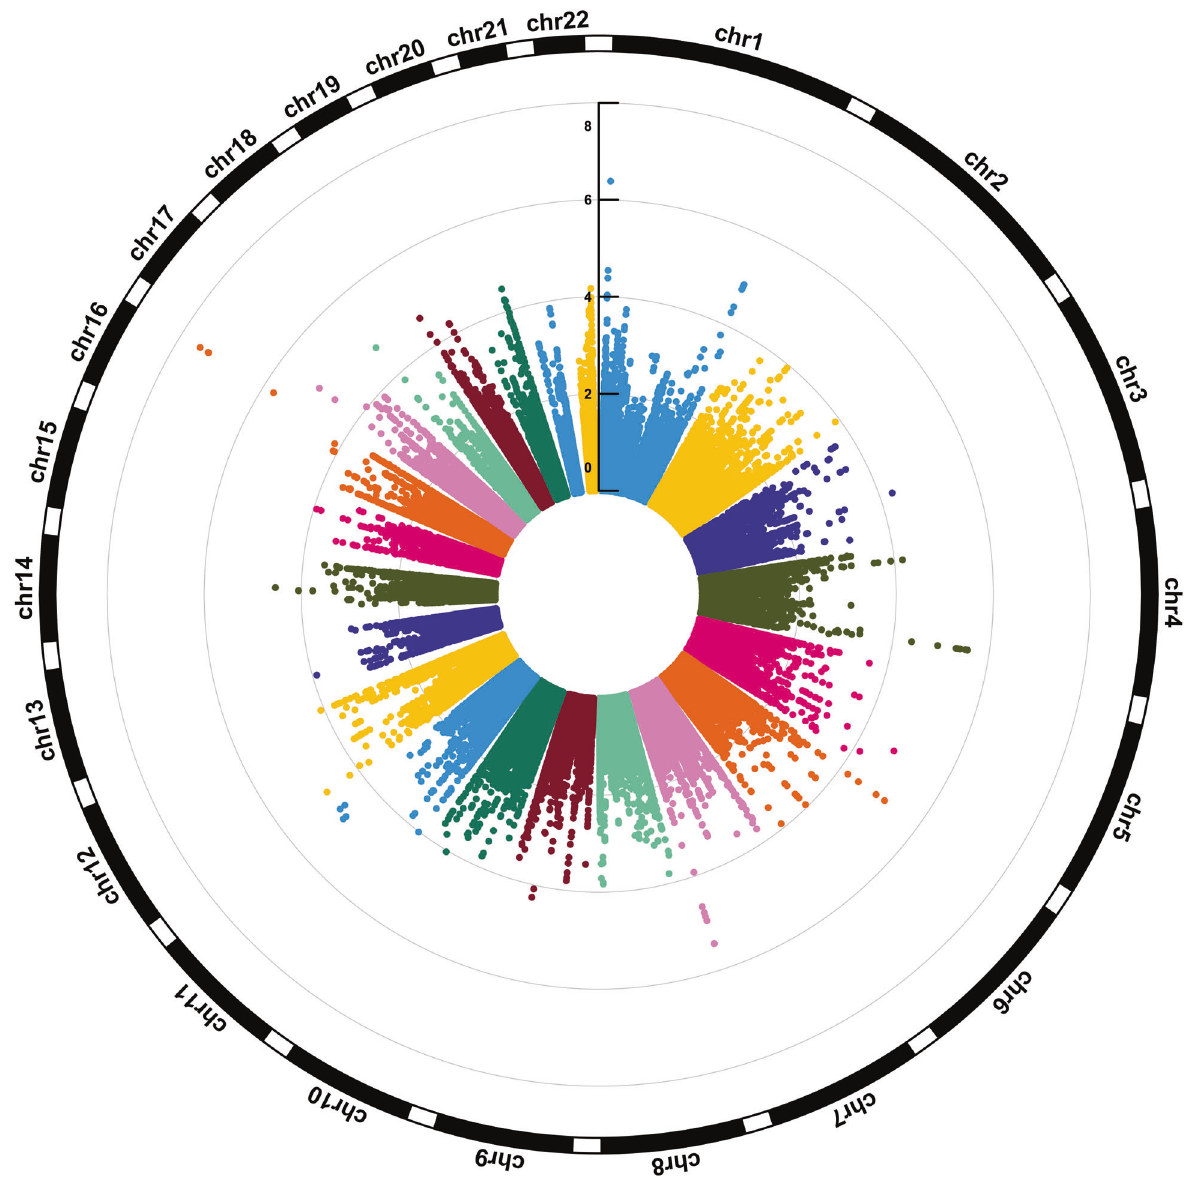
Fig. 1 Circular Manhattan plot for epigenome-wide association study of depression. The numbers of chromosome and the − log 10 of P -values for statistical signi fi cance are shown. The dots represent the observed CpG